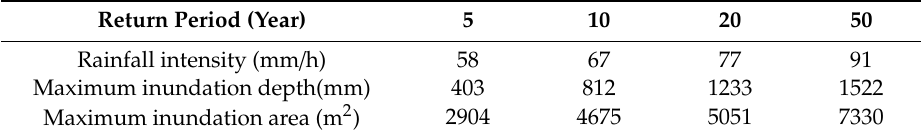
Table 2. Runo ff and inundation data under di ff erent storm